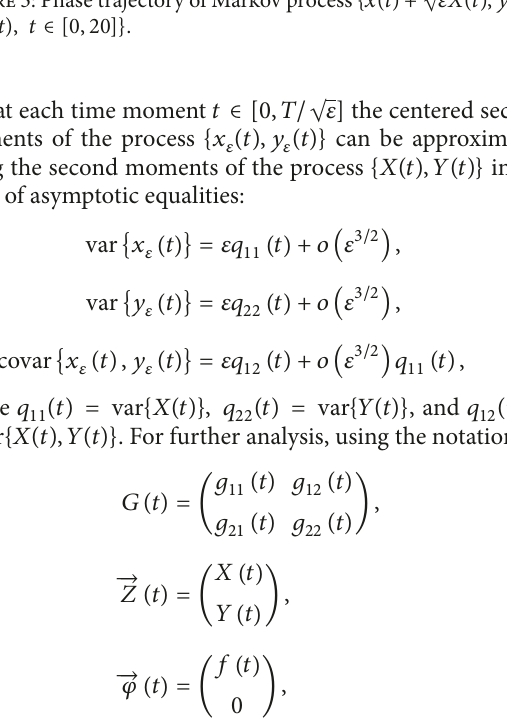
Figure 3: Phase trajectory of Markov process {𝑥(𝑡)+√𝜀𝑋(𝑡),𝑦(𝑡)+ √𝜀𝑌(𝑡), 𝑡 ∈ [0, 20]} .